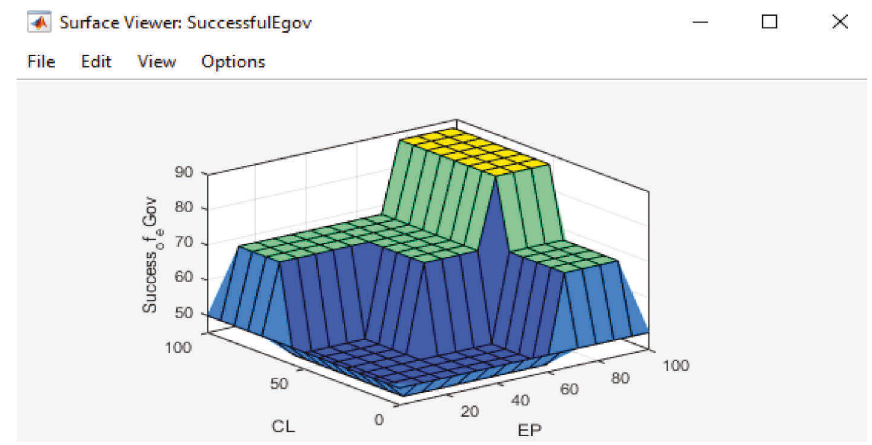
Figure 10: Three dimensional of the EP and CL with the success of